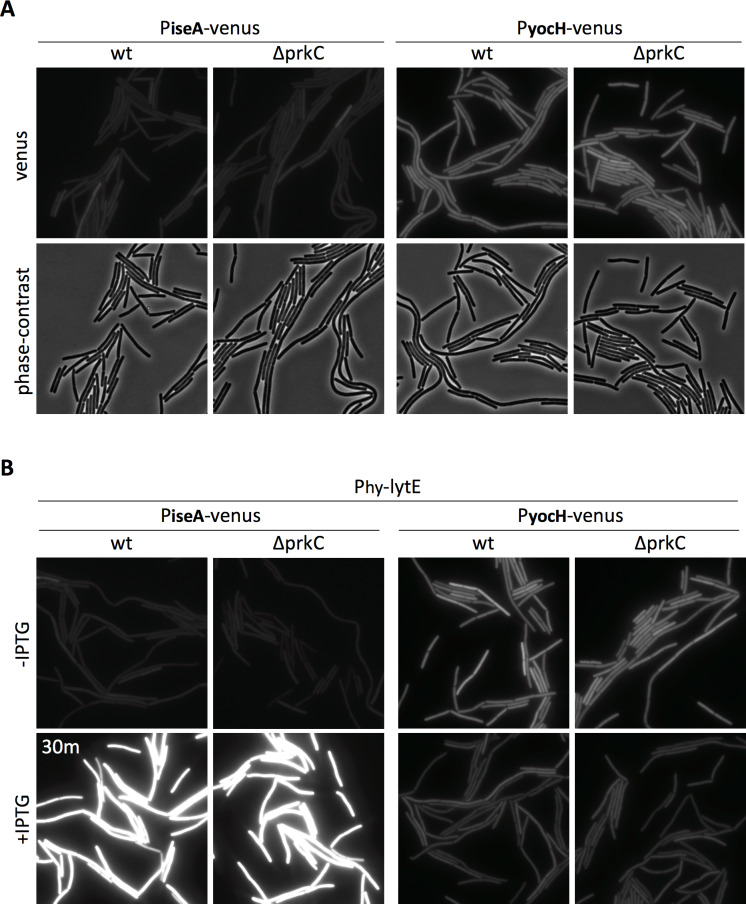
PrkC is not involved in the response to changes in D,L-endopeptidase activity.(A) Representative fluorescence and phase-contrast images of cells harboring the PiseA-venus or PyocH-venus report in wild-type (wt) and the ∆prkC mutant. Cells were grown in LB medium and visualized at an OD600 of ~0.3. (B) Representative images of cells harboring the PiseA-venus or PyocH-venus reporters and Phy-lytE in wild-type (wt) and the ∆prkC mutant. Cells were grown in LB medium to an OD600 of ~0.3 and visualized before and 30 min after addition of 50 µM IPTG.